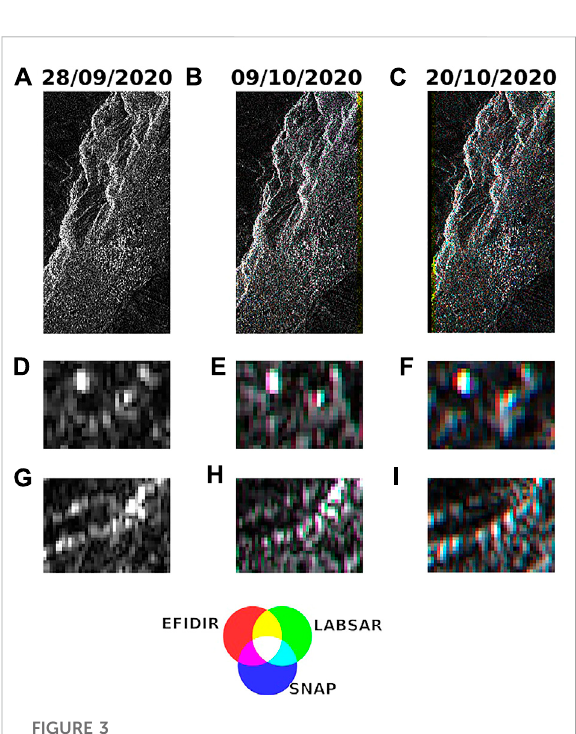
FIGURE 3 Color composition of the intensity of the coregistered image at the same date. Red: the original image as used in the EFIDIR framework, green: LabSAR, and blue: SNAP. (A,D,G) 28/09/ 2020 image, (B,E,H) 09/10/2020 image, and (C,F,I) 20/10/ 2020 image. (A – C) Full image (D – F) zoom on three point-like scatterers in the city of Chamonix (G – I) zoom on a speckle area due to the mountain layover. Since the main image has not been resampled with any of the frameworks, the (A,D,G) images are in